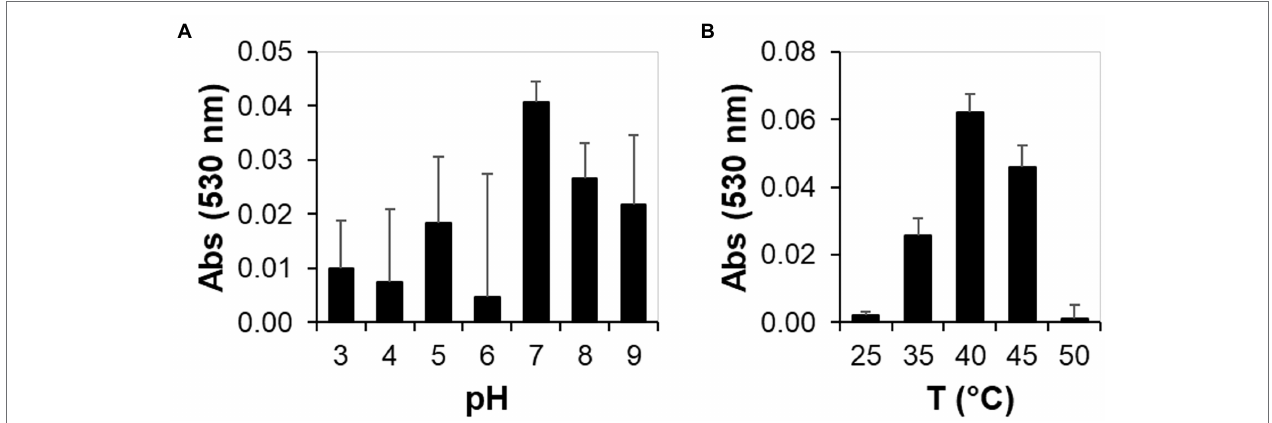
FIGURE 5 | Biochemical activity of plant expressed Lac51 toward syringaldazine under different pH and temperature conditions. Syringaldazine assay was performed in different conditions containing 0.4 μ M Cu 2+ -saturated Lac51, 50 mM Na-acetate, and 30 μ M syringaldazine in a final volume of 0.1 ml with different pH (A) and temperature (B) . The absorbance was measured at 530 nm for over 30 min at 37 ° C.